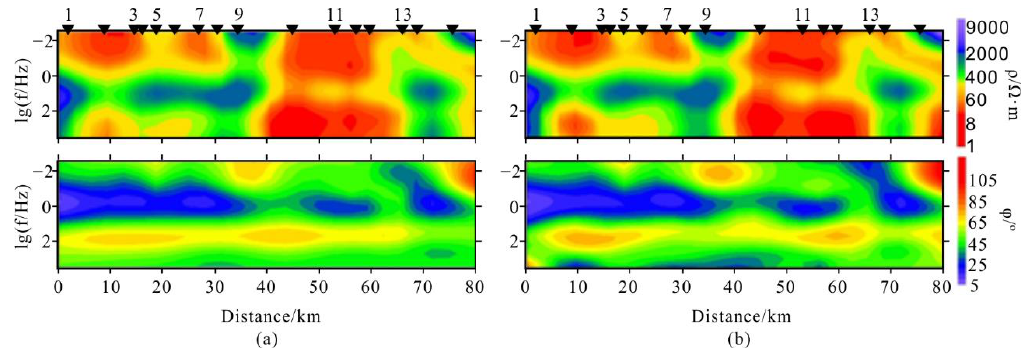
Figure 7. Pseudo-section diagram of measured data ( a ) and response data ( b ) of Tranverse Magnetic (TM) apparent resistivity and impedance phase.